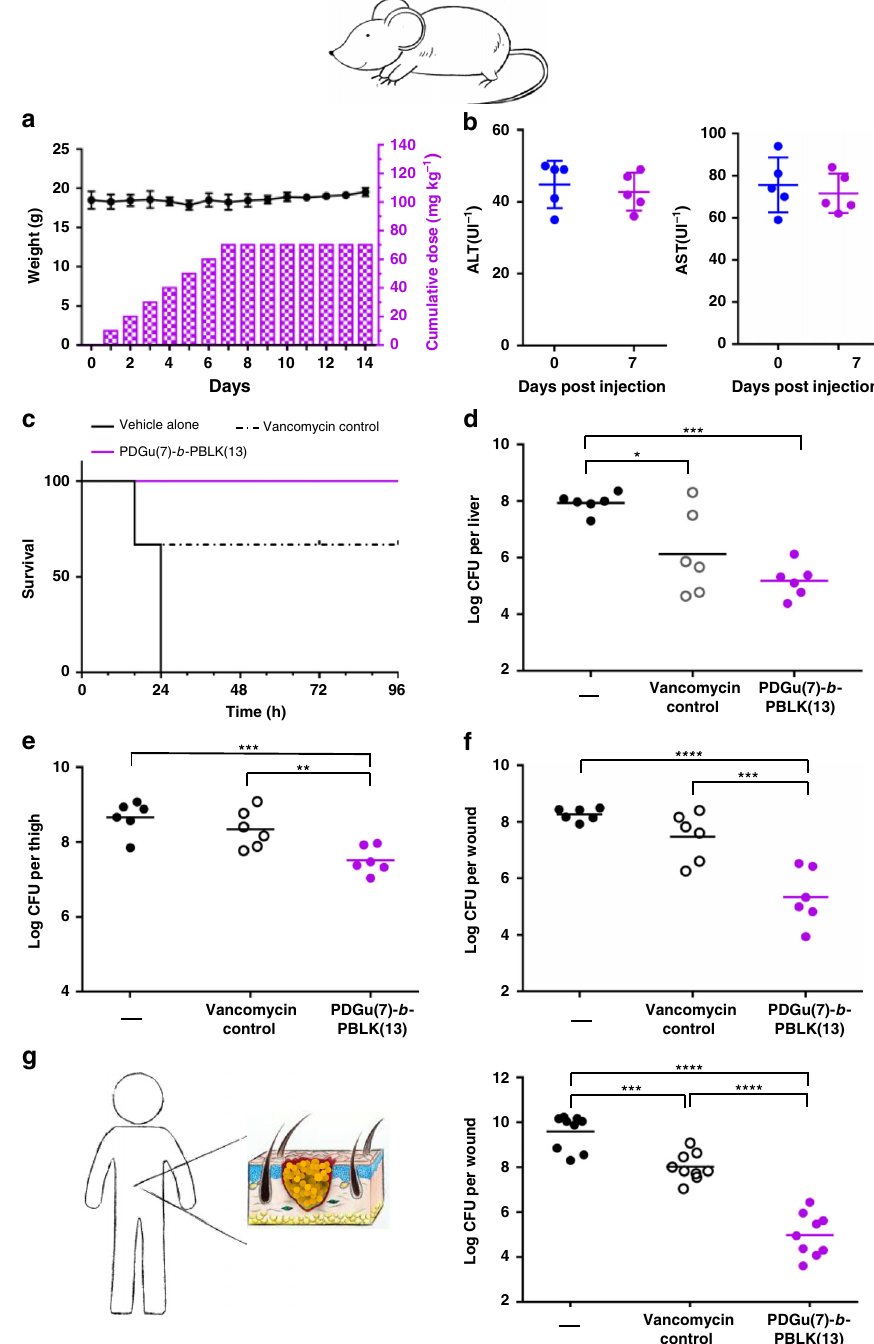
Fig. 6 PDGu(7)- b -PBLK(13) is ef fi cacious in vivo against MRSA USA300 with no toxicity. a , b In vivo repetitive toxicity of daily 10 mg kg − 1 i.v. injection of PDGu(7)- b -PBLK(13) for 7 consecutive days. a Mice weight (left y -axis) and cumulative dosage (right y -axis) over 14 days. b ALT and AST biomarker changes at t = 0 and 7 days. Data are presented as mean ± standard deviation. c Survival% and d bacteria log reduction in liver in a systemic infection model. Vehicle alone ( – ), PDGu(7)- b -PBLK(13) , or vancomycin control at 5 mg kg − 1 were applied at a single dose, 2-h post infection. e In vivo antimicrobial activity of PDGu(7)- b -PBLK(13) against MRSA USA300 in a deep-seated neutropenic thigh infection model. First treatment was applied 24-h post infection at 20 mg kg − 1 , with a second dose at 20 mg kg − 1 applied 3 h later. f In vivo antimicrobial activity of PDGu(7)- b -PBLK(13) against MRSA USA300 in an established murine excision wound model. Vehicle alone ( – ), PDGu(7)- b -PBLK(13) , or vancomycin control at the same dosing (i.e. 2.5 mg kg − 1 ) were applied six times over 2 days, starting 72-h post infection. g Ex vivo antimicrobial activity of PDGu(7)- b -PBLK(13) against MRSA USA300 in an established wounded human skin model. Vehicle alone ( – ), PDGu(7)- b -PBLK(13) , or vancomycin control at 100 µ g were applied three times with 3-h interval between treatments, starting 48 h post infection; ** p ≤ 0.01, *** p ≤ 0.001, **** p ≤ 0.0001 by one-way ANOVA followed by Dunnett